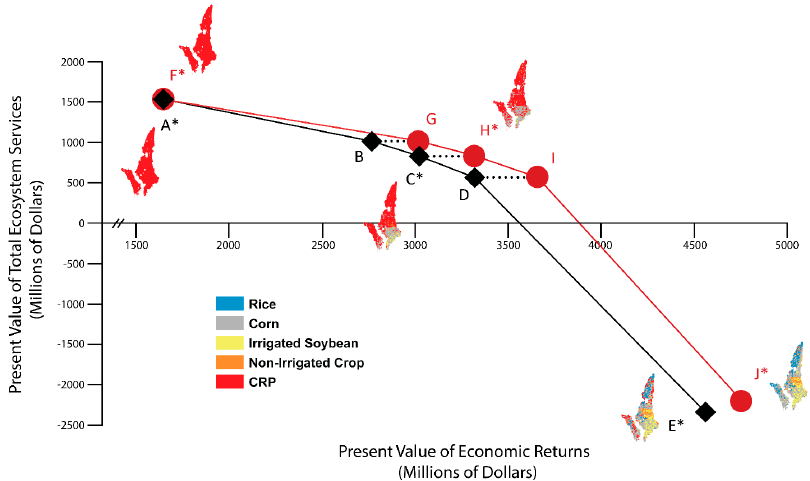
Figure 2. Crop mix patterns associated with specific points along the efficiency frontiers without reservoirs (Points A to E) and with reservoirs (Points F to J). Each crop mix pattern shown beside the efficiency frontiers correspond to a lettered point with an asterisk on the frontiers. Points on the efficiency frontier with reservoirs available have less Conservation Reserve Program (CRP) land and more corn and rice. Emphasizing the ecosystem service objective shifts predominantly irrigated crops to CRP.